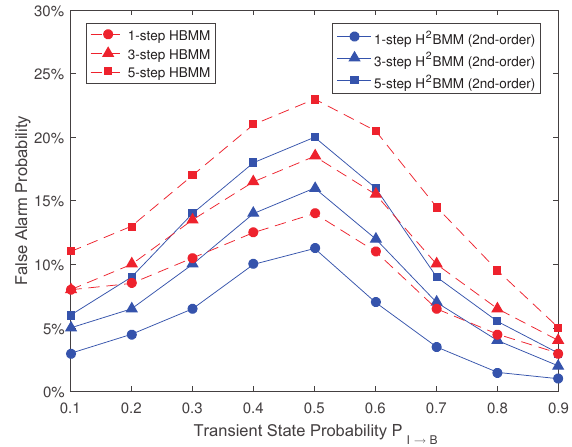
Figure 7. False alarm possibility of HBMM (1st-order) and H 2 BMM